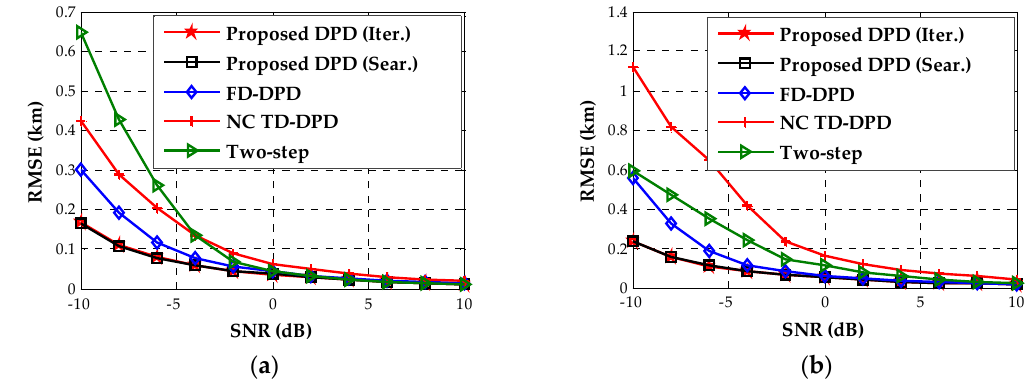
Figure 4. The estimated RMSEs versus SNR for near-field sources. ( a ) Source 1; ( b ) Source 2.